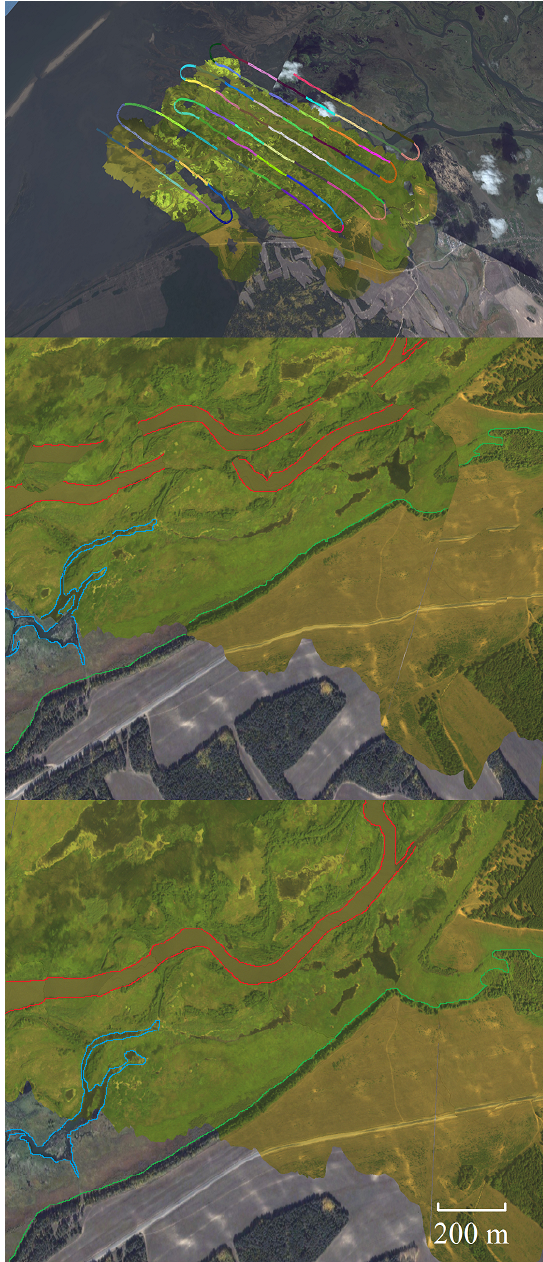
Figure 7. flight path and extract from the projection before and after correction, for flight 2 (Lake Baikal region, Russia).